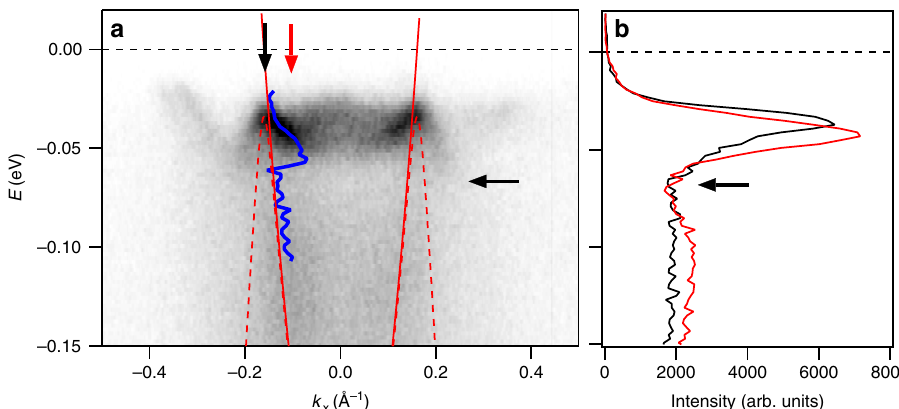
Fig. 4 As grown Bi2212 sample ( T c = 91 K). a Electronic structure near the antinode along the momentum line indicated in Fig. 1b at low temperature ( T (cid:2) 12 K) for the as-grown Bi2212 sample. The MDC- fi tted dispersions of the bonding state is indicated by the blue curve. The TB dispersion is indicated by the solid red curve. The dashed red curve represents the TB dispersion gapped by Δ 0 ¼ 34 meV. b The energy distribution curves corresponding to the k (black) and the momentum indicated by the red vertical arrow in a . The horizontal black arrow indicates the dip in the F